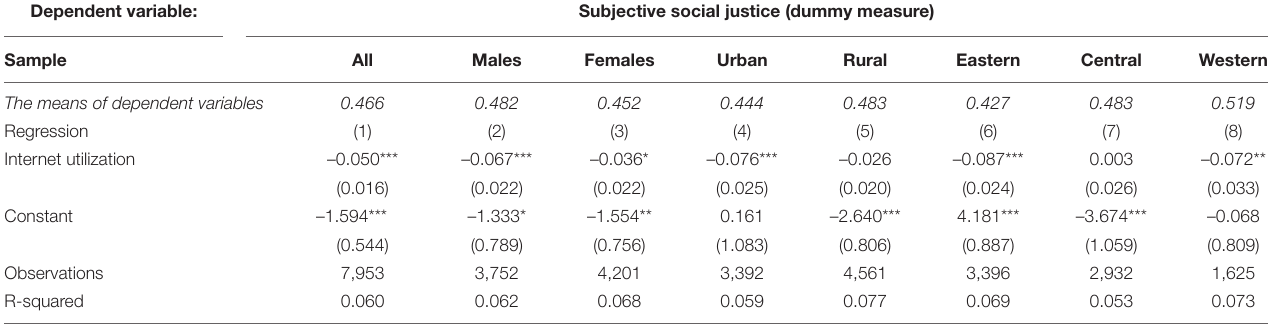
TABLE 5 | Heterogeneous effects within different